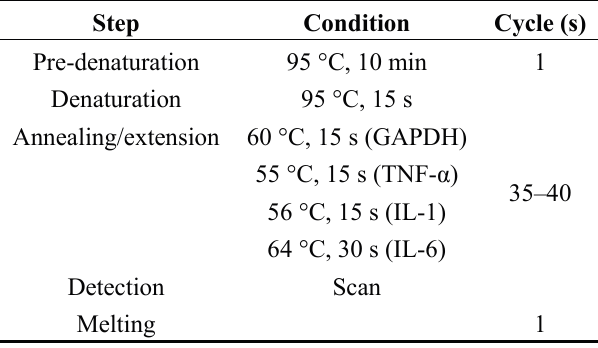
Table 2. qPCR procedure for each